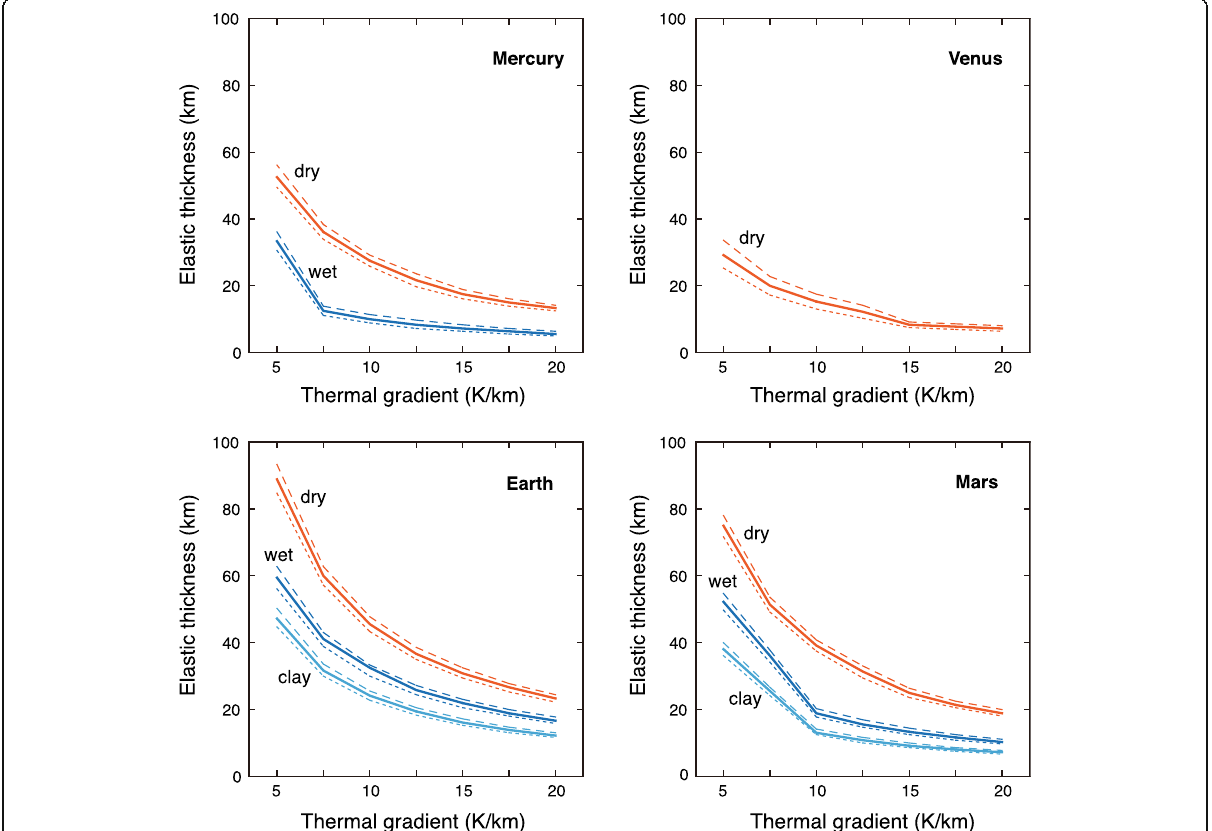
Fig. 8 Effect of thermal gradient on elastic thickness for each planet for various models. Dashed, solid, and dotted lines indicate calculation results using strain rates of 10 − 16 , 10 − 17 , and 10 − 18 s − 1 , respectively. In the calculations, a tensional stress field is assumed at shallow depths, which shifts to compression at greater depths. The parameters for the calculations are listed in Tables 1 and 2